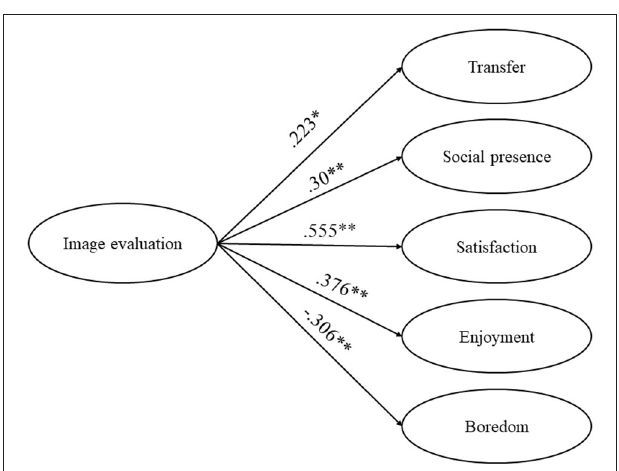
FIGURE 3 | Results of the linear regression of image evaluation on each variable.